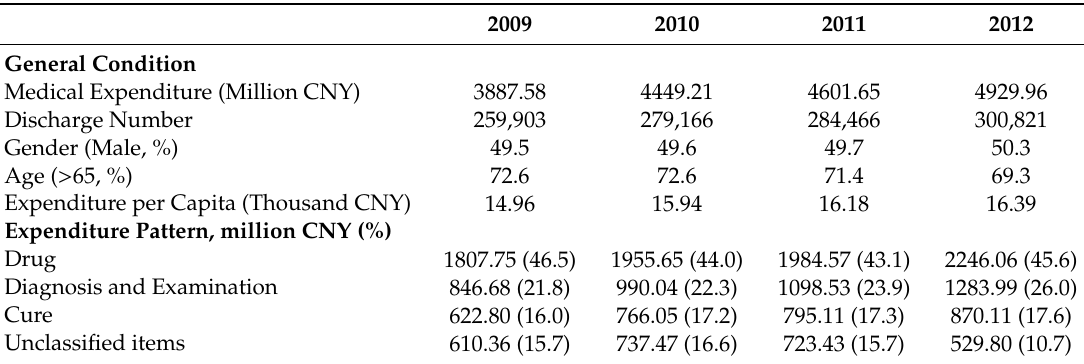
Table 1. Basic information of the sample during study